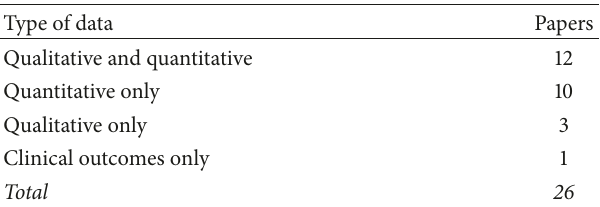
Table 4: Data reported in papers.